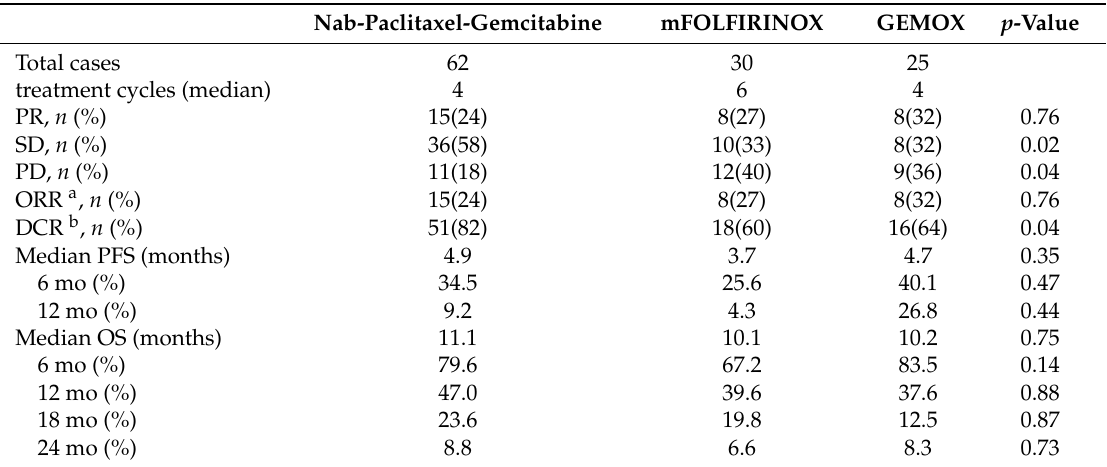
Table 2. E ffi cacy of three di ff erent first-line regimens in patients with unresectable pancreatic cancer. Nab-Paclitaxel-Gemcitabine mFOLFIRINOX GEMOX p